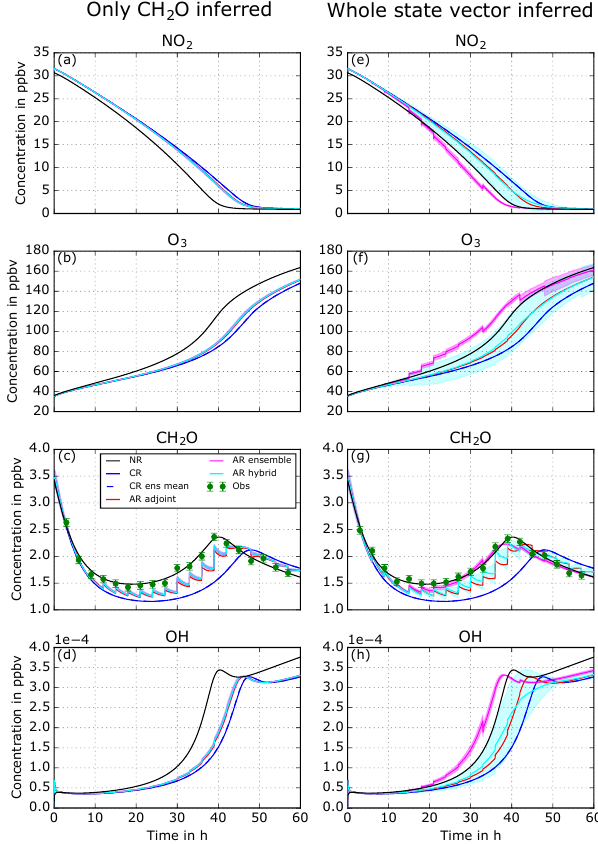
Figure 6. Same as Fig. 5 but with CH 2 O observations